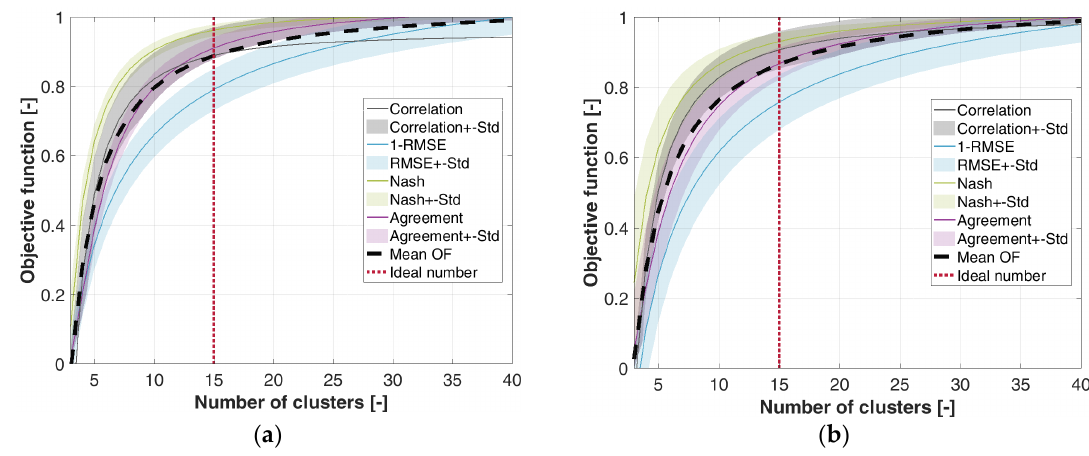
Figure 2. Number of Clusters in relation to standardized objective functions. All criteria were set to the same range (0 = no agreement, 1 = perfect agreement). ( a ) Impulse boundary condition; ( b ) Dynamic boundary condition. Correlation = Pearson correlation coe ffi cient, RMSE = root mean square error, Nash = model e ffi ciency [32], Agreement = Index of agreement, Mean OF = arithmetic mean out of all objective functions. “Std” denotes for standard deviation.